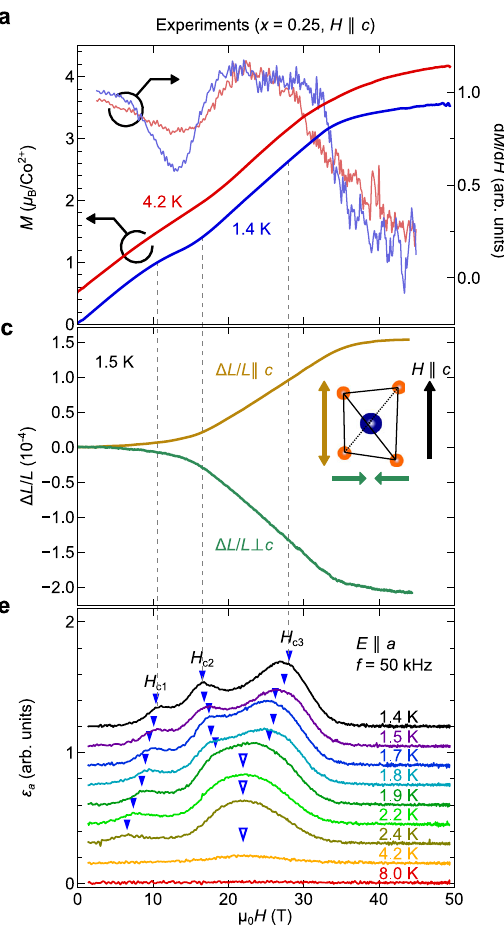
Fig.3|Magnetic fi elddependenceofphysicalpropertiesofBCZGO.a Magnetic- fi eld dependence of magnetization M and its fi eld derivatives d M /d H . Each M – H curve is offset vertically for clarity. c Magnetostriction, measured for the striction along the c -axis (yellow, Δ L / L ∥ c ) and perpendicular to the c -axis (green, Δ L / L ⊥ c ). e Magnetic fi elddependenceof ε a atvarioustemperatures.Each ε – H curveisoffset vertically for clarity. Phase boundaries are de fi ned as blue-closed triangles